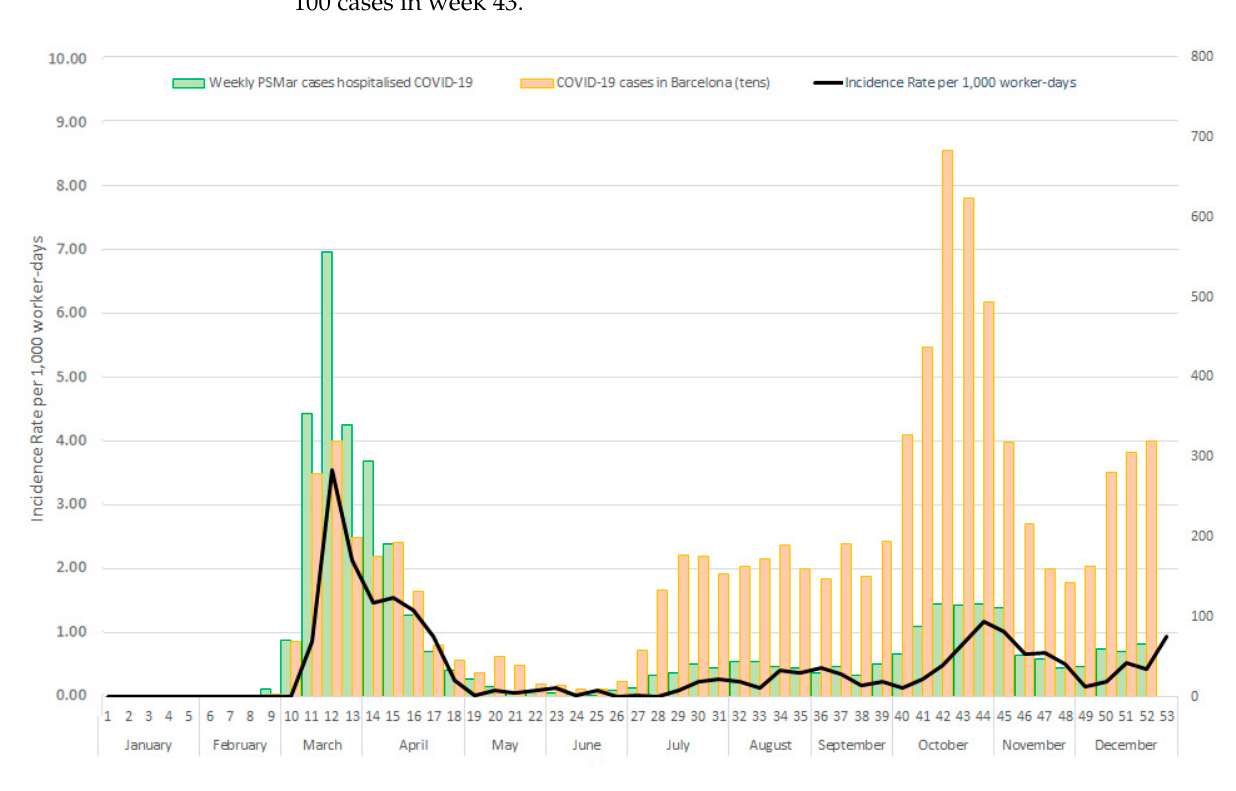
Figure 1. COVID-19 IR per 1000 worker-days among PSMar healthcare workers, hospitalised COVID-19 cases, and COVID-19 cases in Barcelona city by weeks.